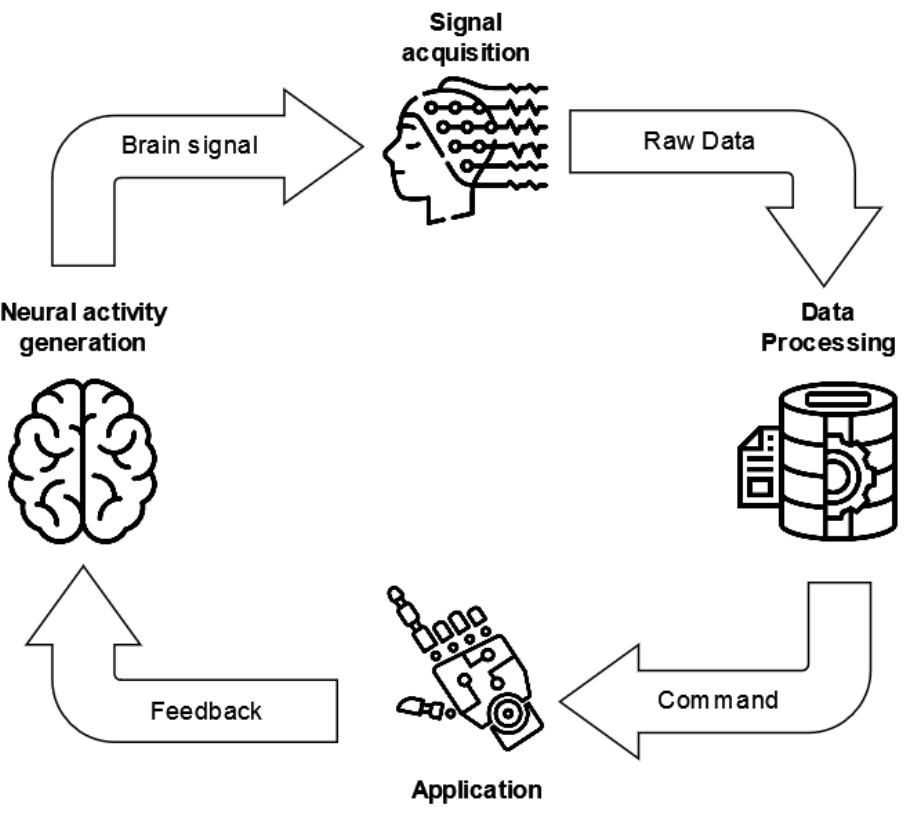
Figure 5. BCI system standard life cycle. The three main modules are reported, i.e., the signal acquisi- tion, data processing, and application